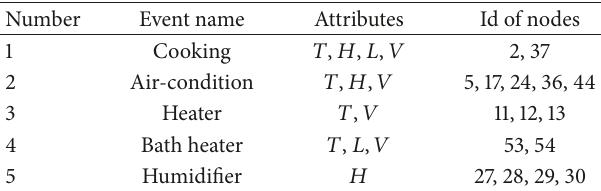
Figure 5: Influence of the three thresholds on the test results. Table 1: False abnormal events.